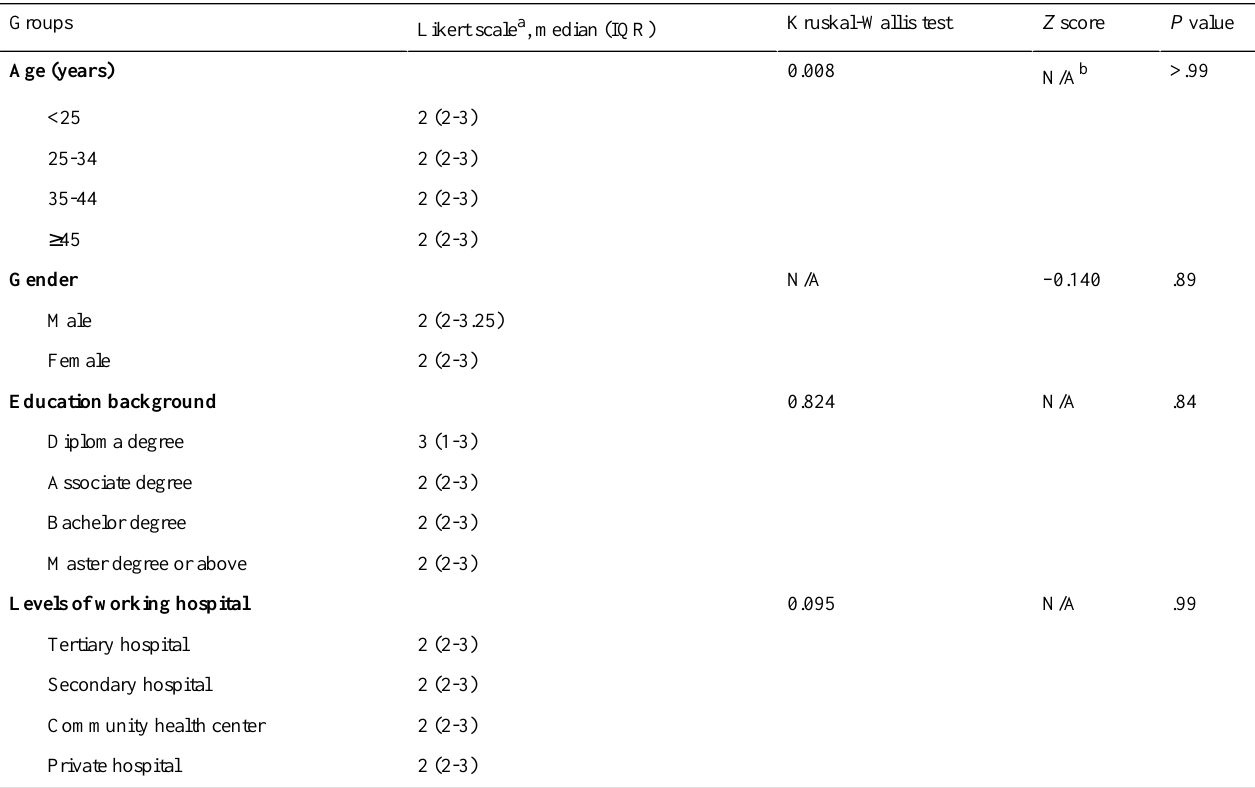
Table 5. Attitude toward the perspective of the sharing nursing